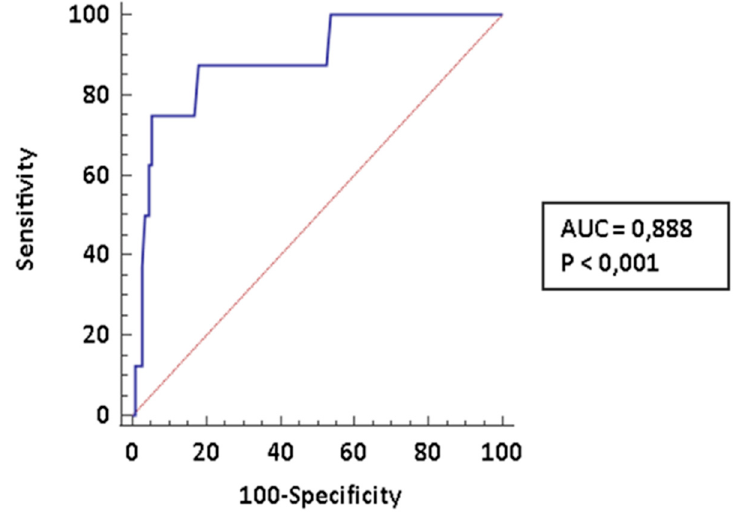
Figure 2. ROC curve for peak VE/VCO 2 slope. We diagnosed 8 CTD-PAH. For abbreviation: AUC, Area under the curve.